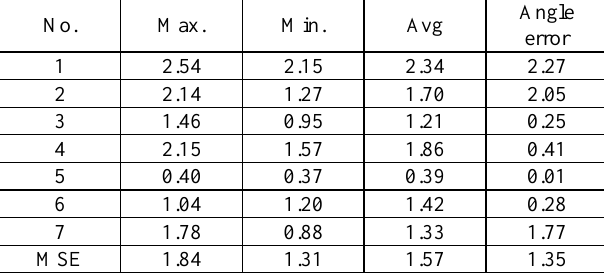
Figure 8. The registration of iamge and point cloud in Vaihingen